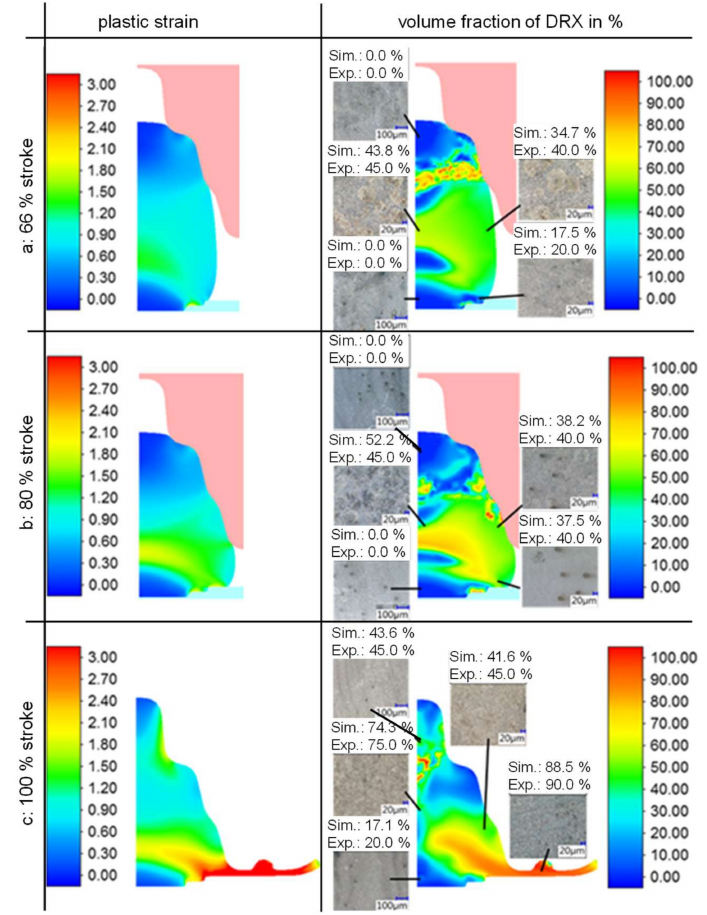
Figure 4. Comparison of simulated and measured microstructure evolution (after quenching) for different forming strokes/gravure fillings. ( a ) 66% stroke (80 mm ram movement, 50 mm height reduction); ( b ) 80% stroke(92 mm ram movement, 62 mm height reduction); ( c ) 100% stroke (106 mm ram movement, 76 mm height